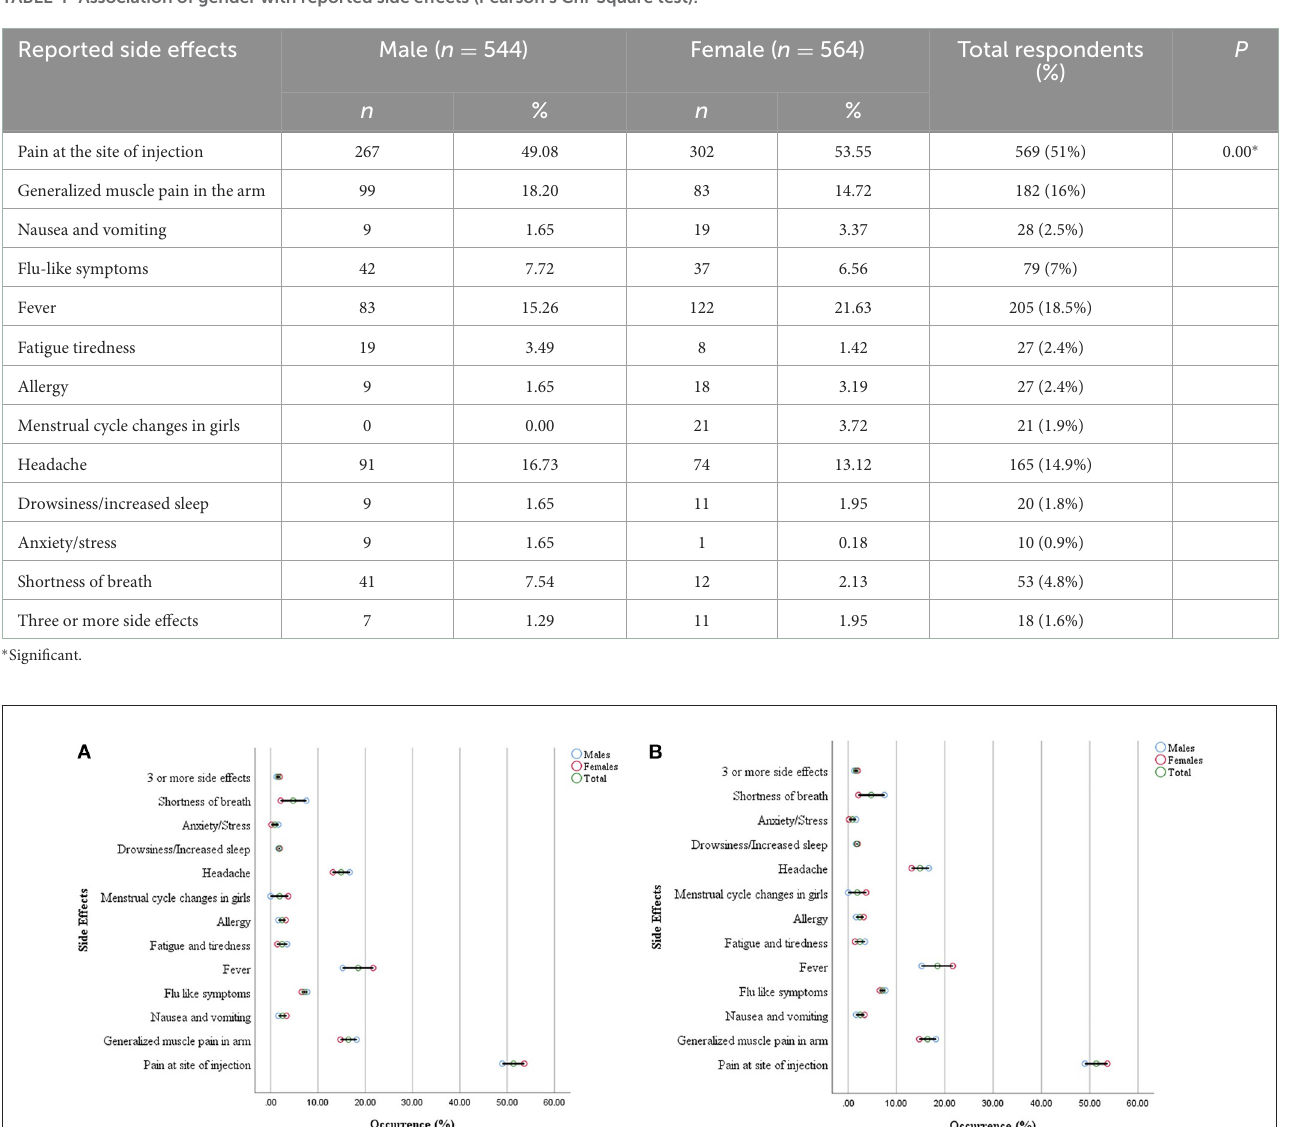
TABLE 4 Association of gender with reported side effects (Pearson’s Chi-Square test).